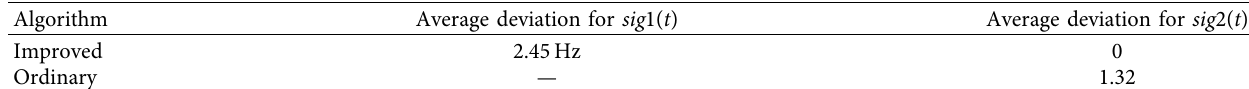
Table 2: The average deviation of two algorithm.